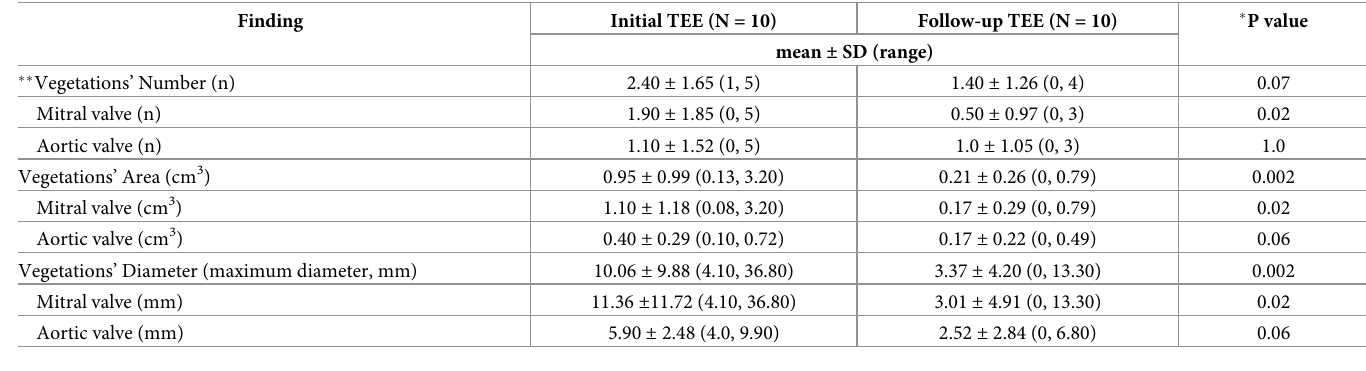
Table 4. Effect of medical therapy in patients with Libman-Sacks vegetations assessed by three-dimensional TEE. Finding